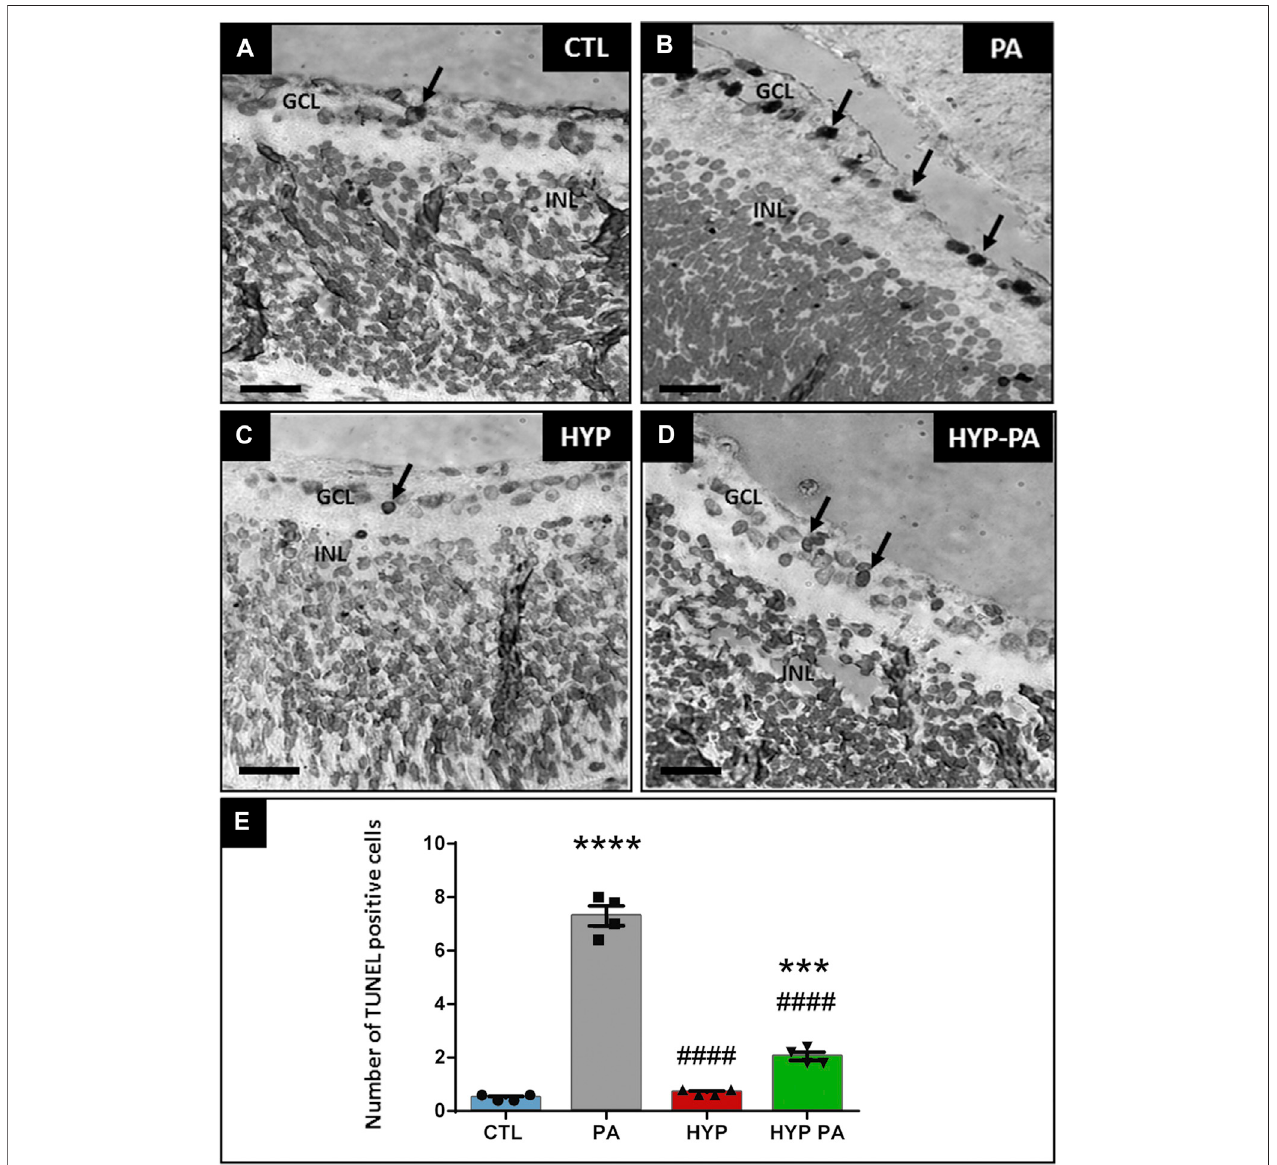
FIGURE 4 | Apoptosis induced by perinatal asphyxia is prevented by hypothermia. Representative images of apoptotic cells (arrows) localized in the ganglion cell layeraslabeledbytheTUNELassayinthefourexperimentalgroups:control(CTL, (A) ),normothermicperinatalasphyxia(PA, (B) ),hypothermiaduringperinatalasphyxia (HYP, (C) ), and hypothermia after perinatal asphyxia (HYP-PA, (D) ). GCL: ganglion cell layer. INL: inner nuclear layer. Scale bars: 40 µm. (E) : Graphical representation of TUNEL-positivecellnumber.PAgroupshowedasigni fi cantincrementinthenumberofTUNELpositivecellscomparedtoCTLgroup.Hypothermia(HYPandHYP- PA groups) signi fi cantly prevented apoptosis induction. Two way ANOVA, signi fi cant interaction F (cid:2) 244.5, p < 0.0001, Tukey´s multiple comparison test, p < 0.0001 (CTL vs. PA), p < 0.001 (CTL vs. HYP-PA), p < 0.0001 (PA vs. HYP and PA vs. HYP-PA), p (cid:2) 0.0025 (HYP vs. HYP-PA). Each bar represents the mean ± SEM of 5 animals. Asterisks indicate signi fi cant differences with CTL. ***: p < 0.001; ****: p < 0.0001. Pound signs indicate signi fi cant differences with PA. ####: p < 0.0001.